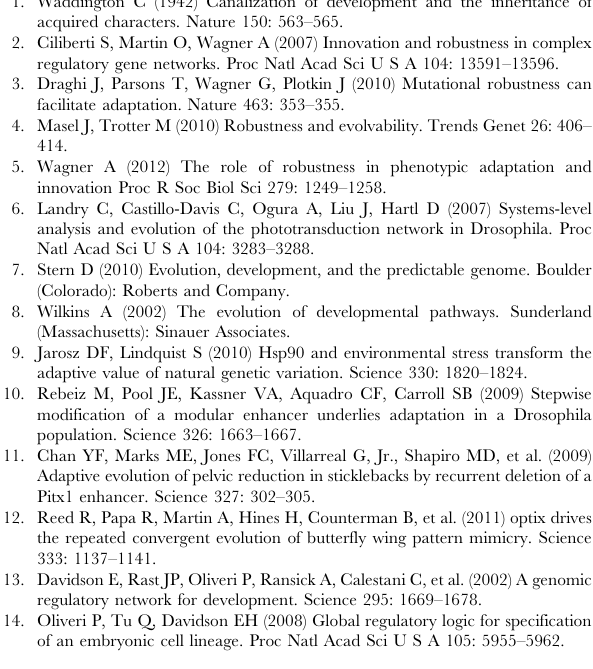
Table S9 By combining the gene expression contribu- tions to each of the six axes weighted by the eigenvalue corresponding to each axis, we get a measure of the overall contribution of each gene_time expression to the overall relationship between gene expression and skel- etal variation. Above are the top 5% of total the weighted contributions of expression measurements to the overall correla- tion between gene expression and skeletal variation. Table S10 Edge activity. This table describes each edge extracted from the Biotapestry database, the times at which the interaction occurs, the region in which it takes place, and whether the interaction is activating or repressive. The times correspond to the time points shown in Figure 1A. Note: only genes shown in Figure 1B were considered in this